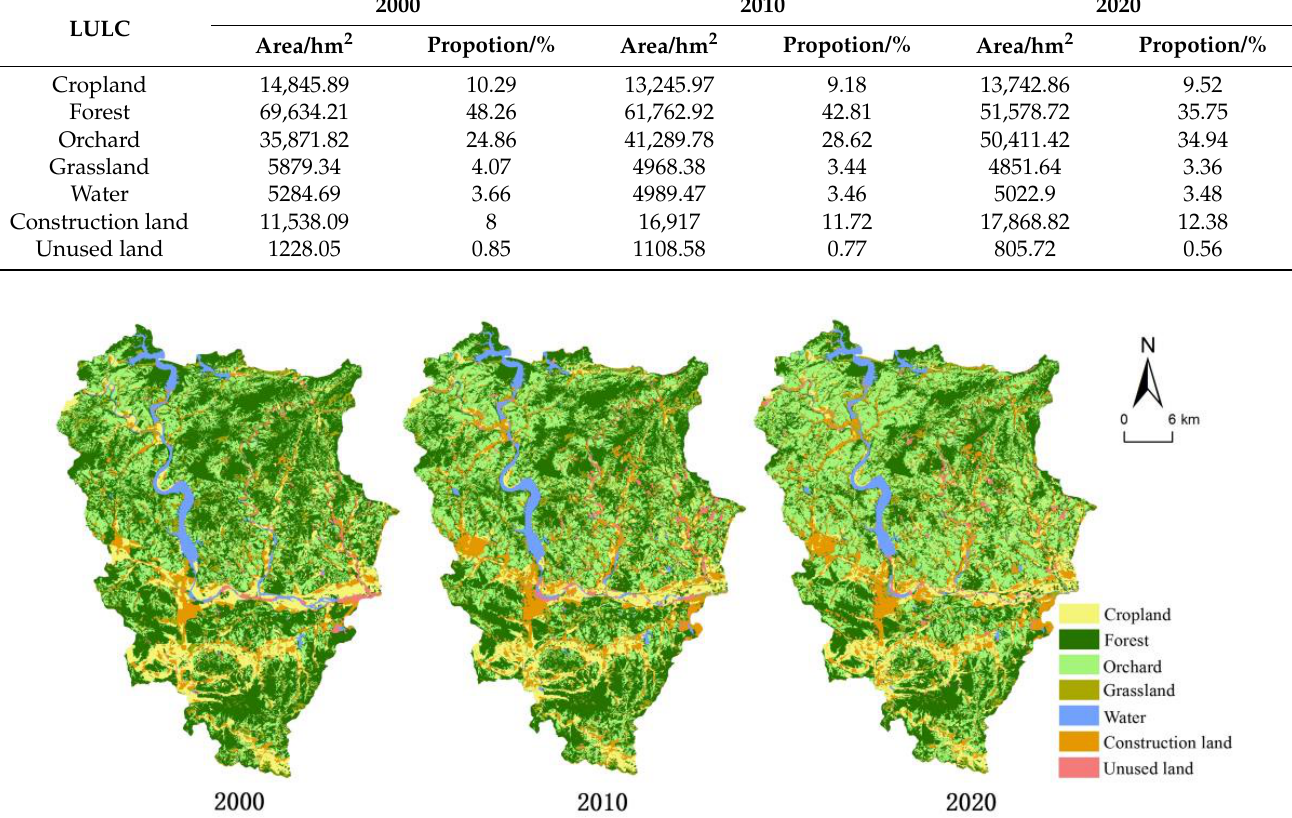
Figure 4. Spatial distribution map of LULC.